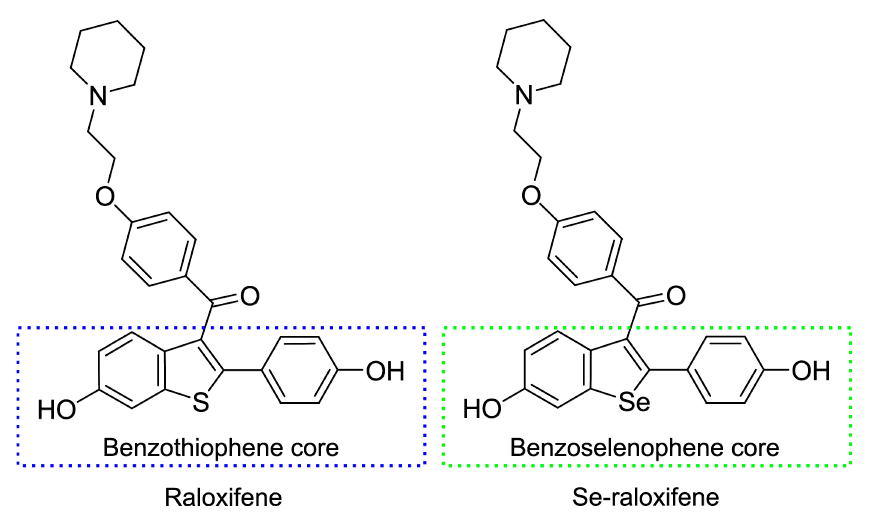
Figure 5. Structures of raloxifene and its Se analogue with the benzothiophene and benzoselenophene cores, respectively. The benzoselenophene core is Compound 1 in our study.